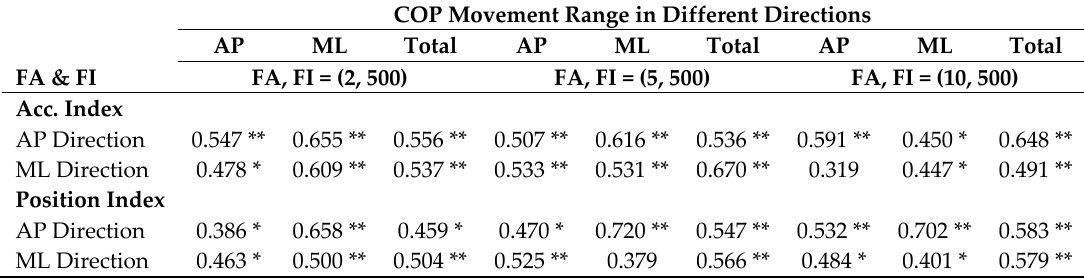
Table 3. The correlation coefficients and their significance between indices and COP movements during static balance test, using different activity and index frequencies.